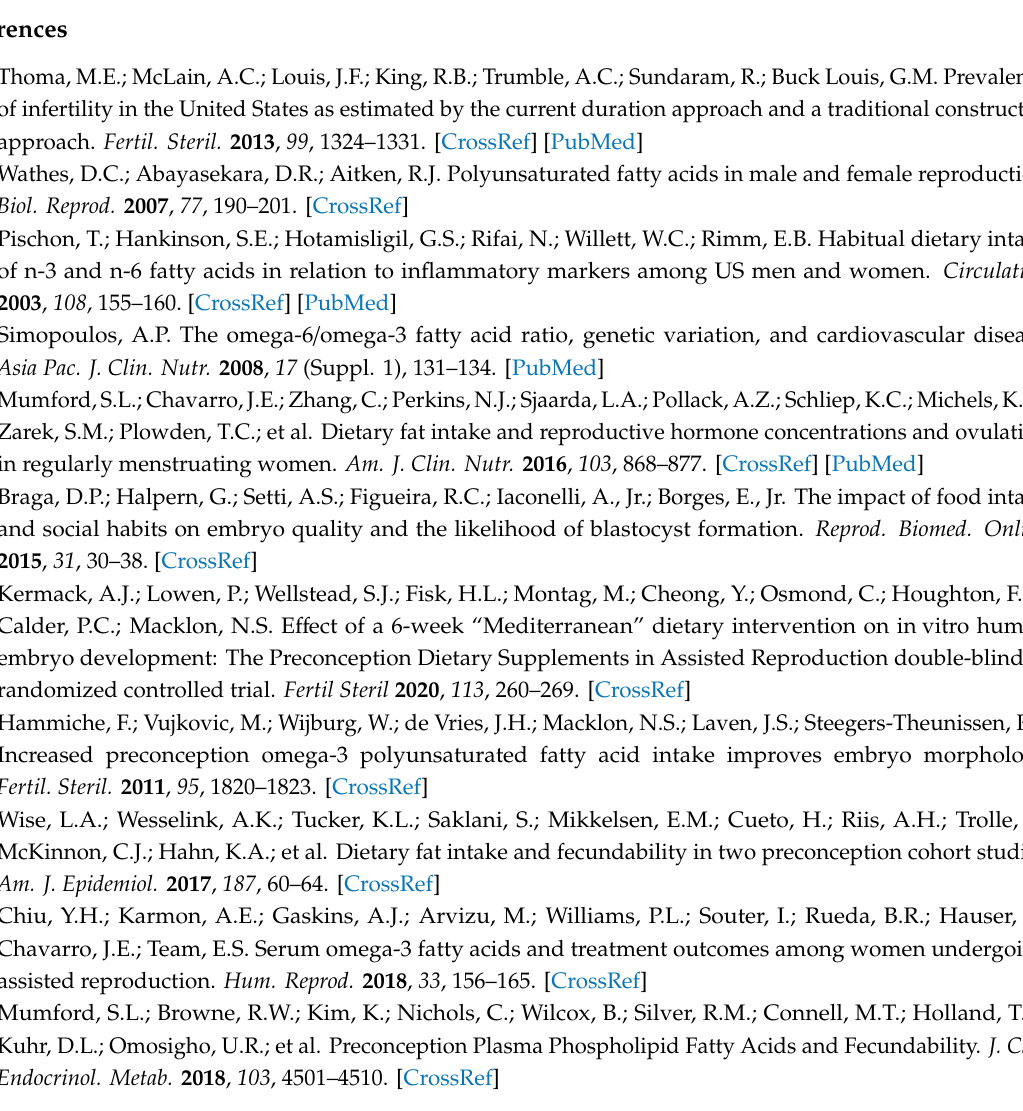
Supplemental Table S1. Questions on seafood intake from food frequency questionnaires in each cohort. Supplementary Table S2. Association between seafood intake and fecundability, stratified by age at baseline. Supplementary Table S3. Association between seafood intake and fecundability, stratified by body mass index. Supplementary Table S4. Association between seafood intake and fecundability, stratified by pregnancy attempt time at cohort entry. Supplementary Table S5. Association between seafood intake, marine fatty acids, and fecundability, among non-consumers of fish oil